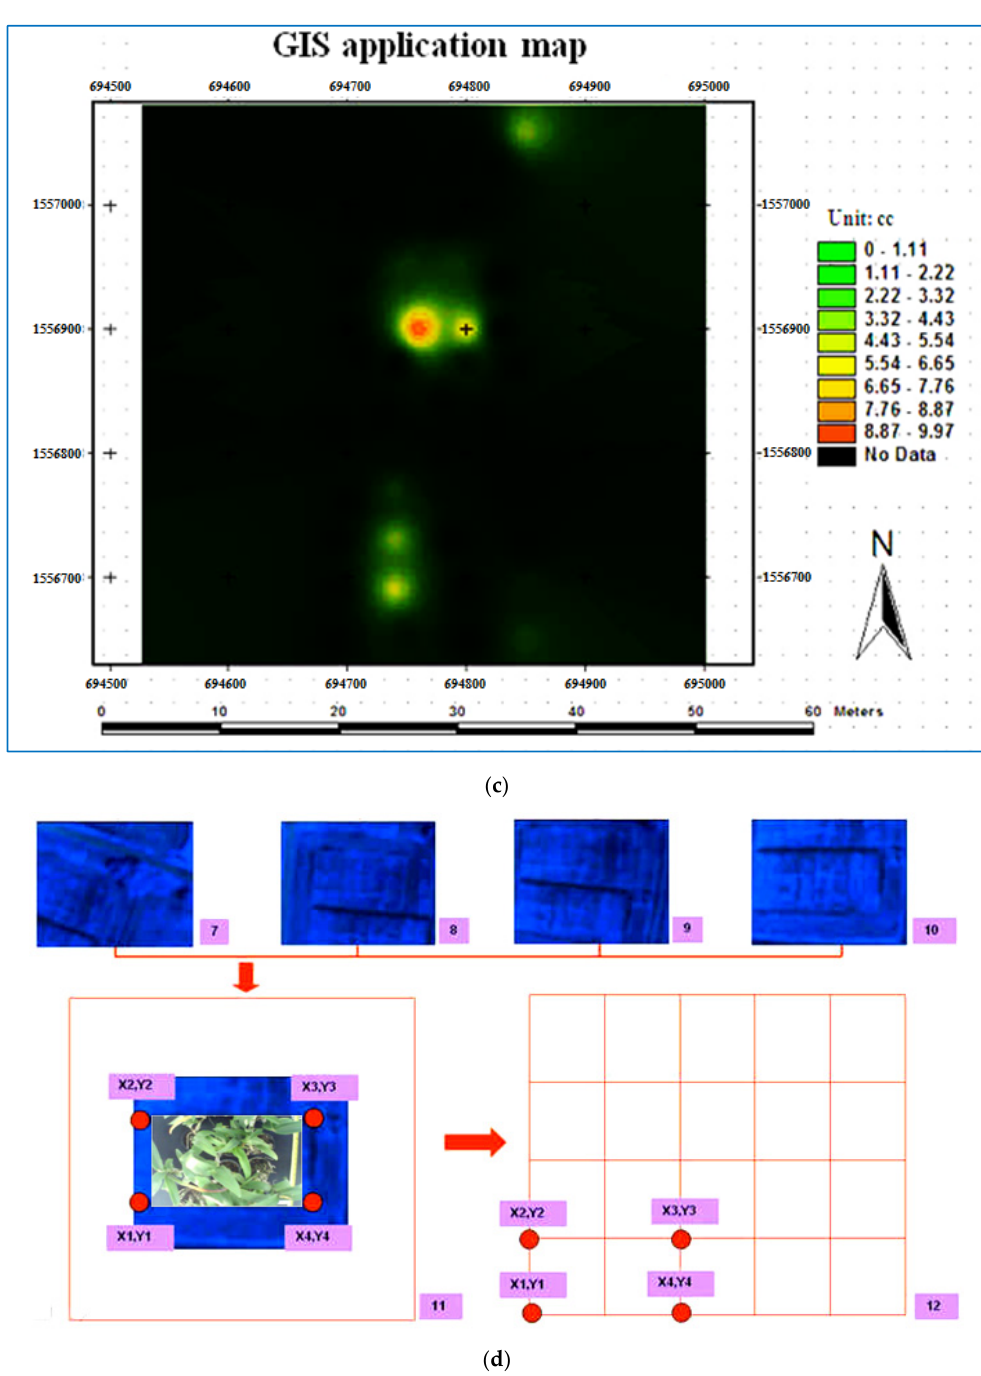
Figure 9. GIS application maps for crop status monitoring and spraying ( a ) The crop growth density segmented from wireless WebCAMs, ( b ) The infestation of pest and diseases segmented from wireless WebCAMs, ( c ) GIS application map (units are cc.), ( d ) The combination of plot-based images of wireless WebCAMs.